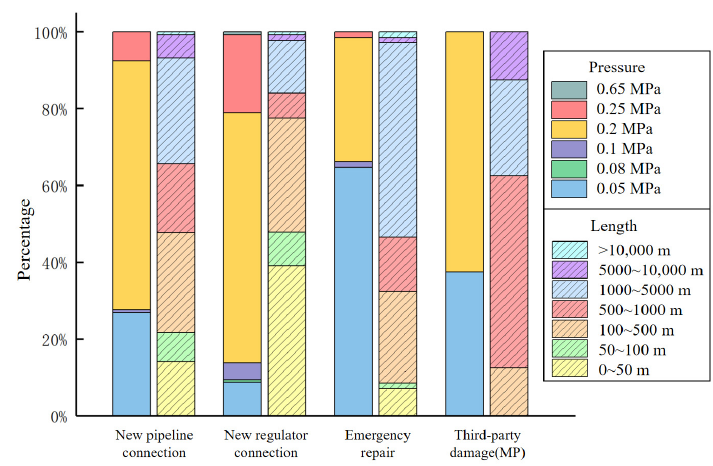
Figure 7. Distribution of pressure and length of emission sources.